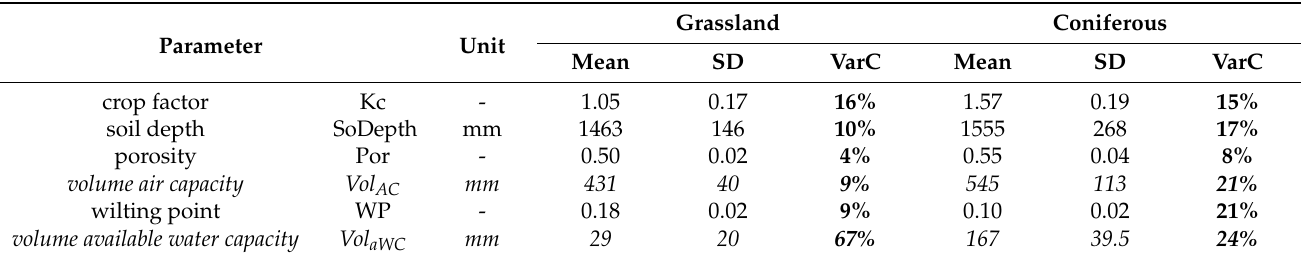
Table 8. Mean (mean), standard deviation (SD) and variation coefficient (VarC) for last population of calibration-runs for grassland and coniferous.